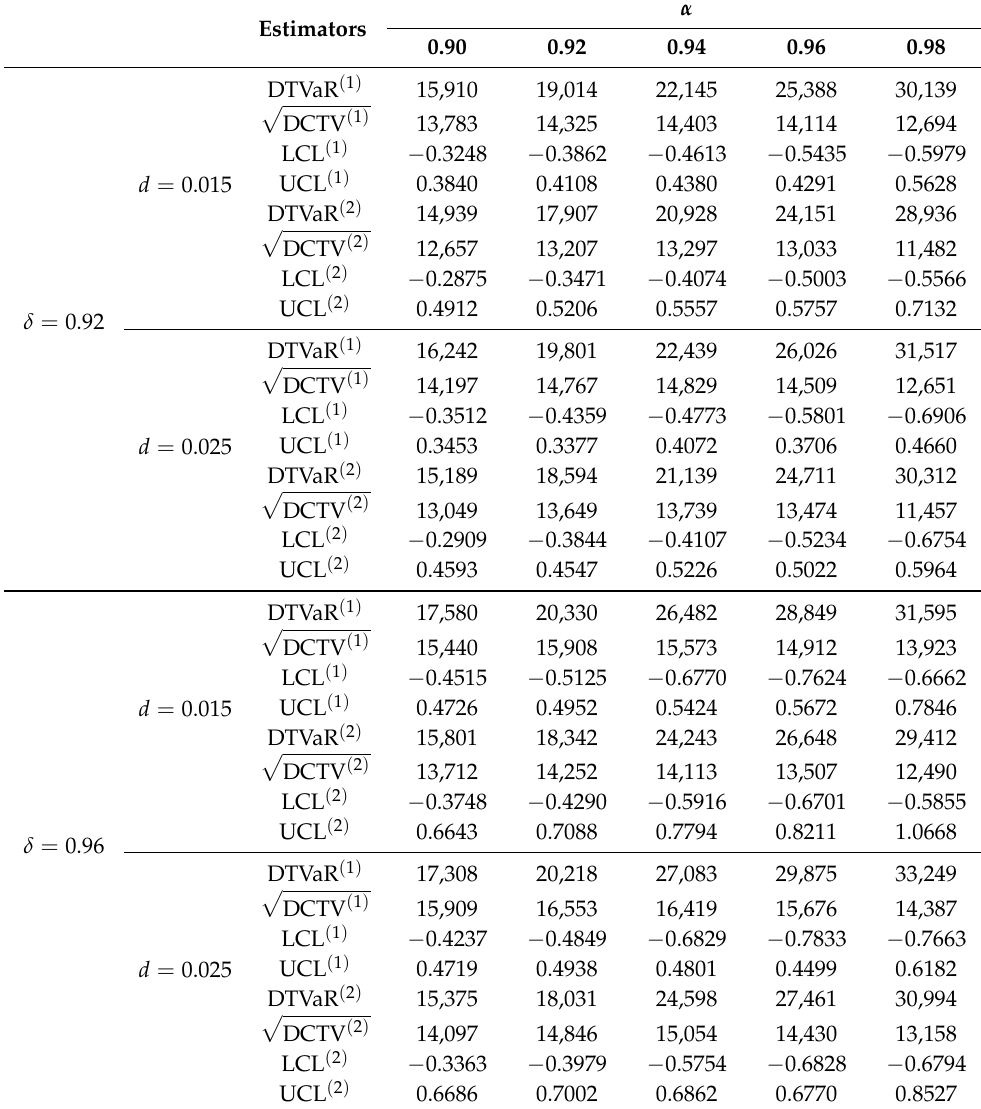
( δ , d ) ( X | Y ; C ) estimates and bootstrap confidence Table 4. DTVaR ( α ,0 )